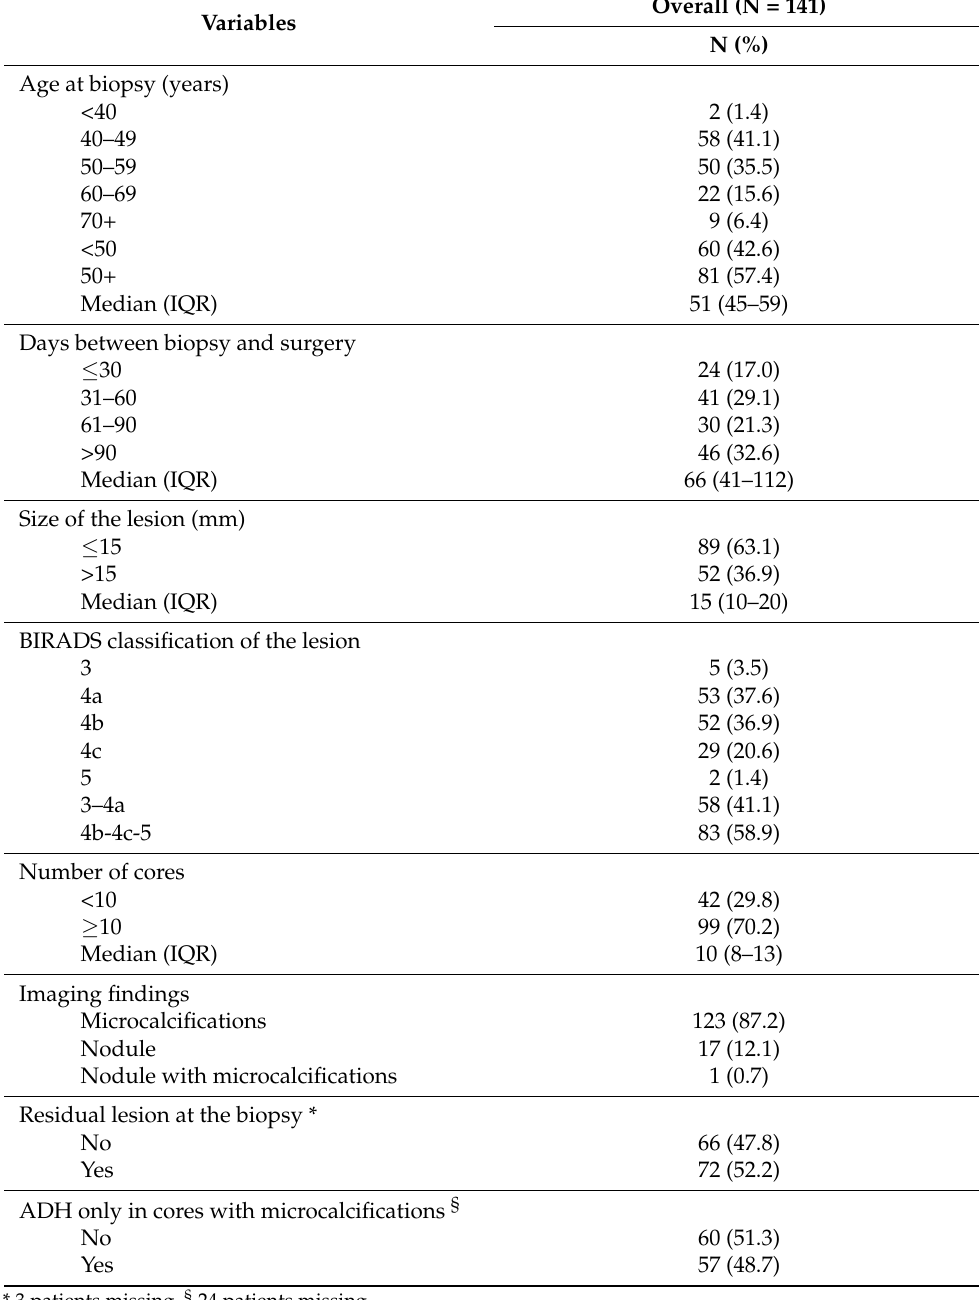
Table 1. Characteristics of patients (N =